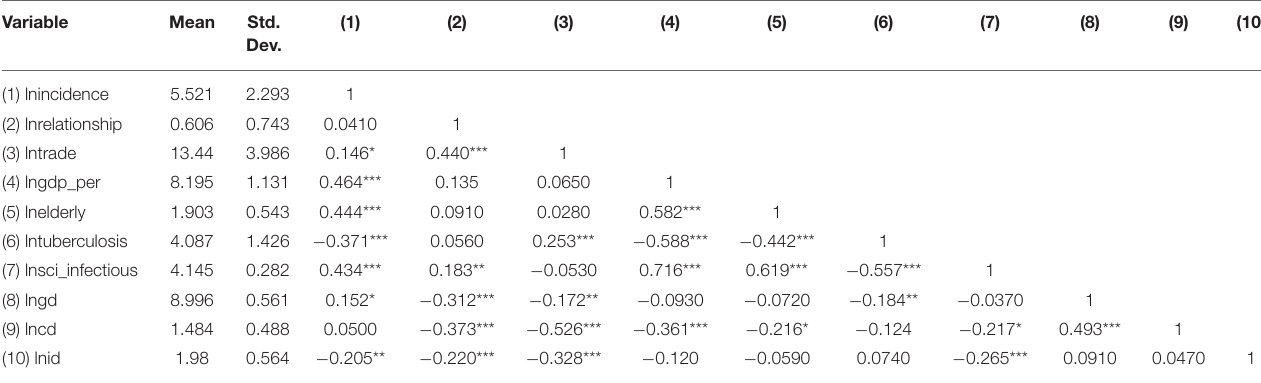
TABLE 2 | Descriptive statistics and correlation coefficient matrix of variables. Variable